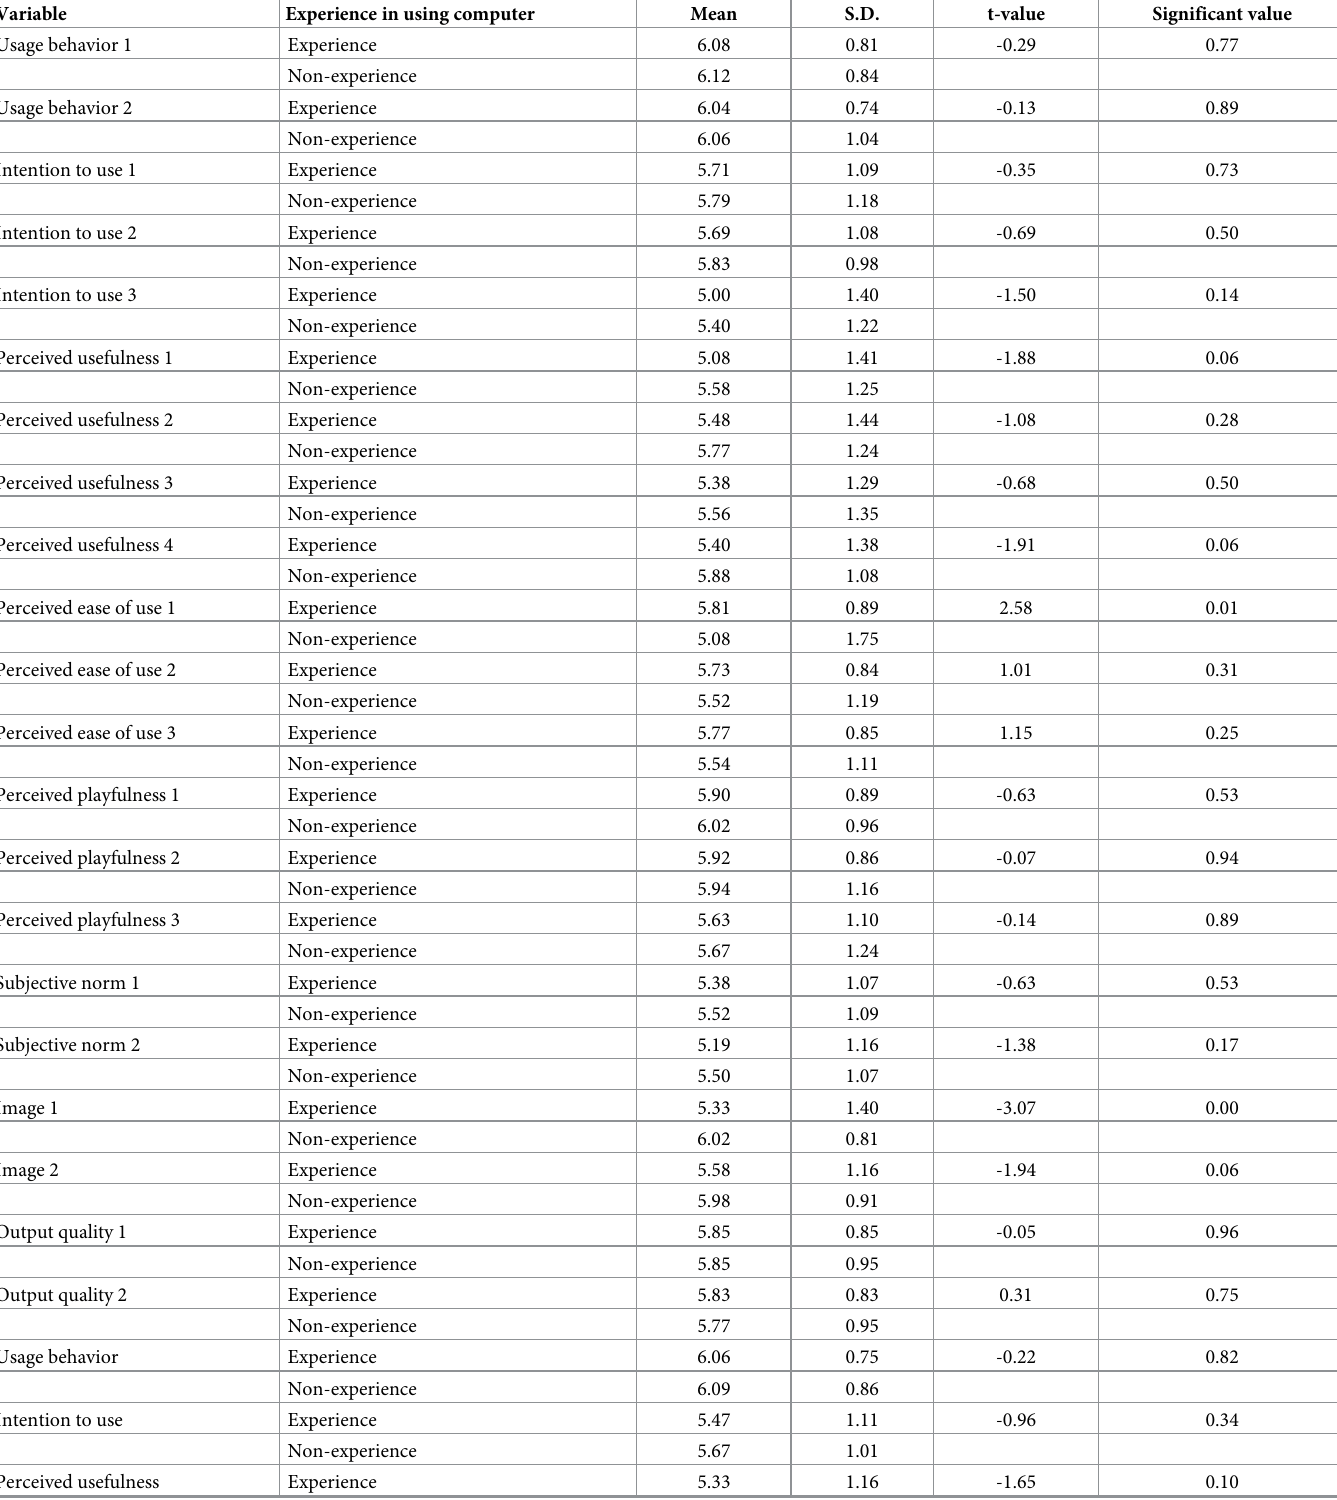
Table 1. t-test on physical exergames between experienced and non-experienced computer users on the questionnaire items and variables.